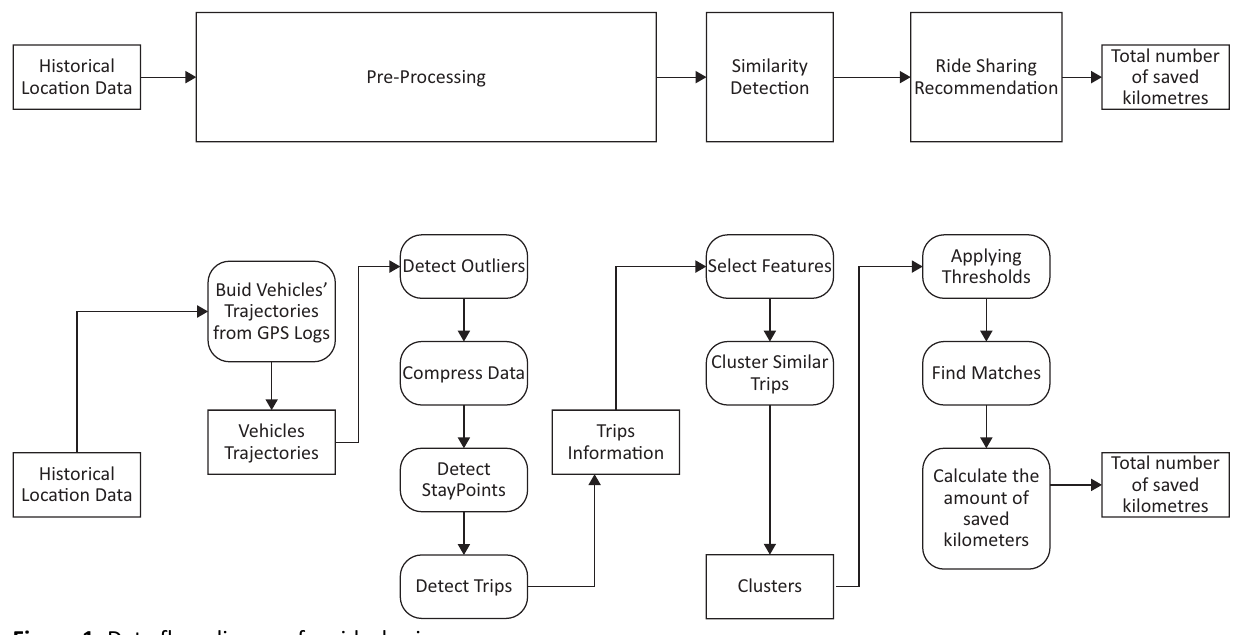
Figure 1. Data flow diagram for